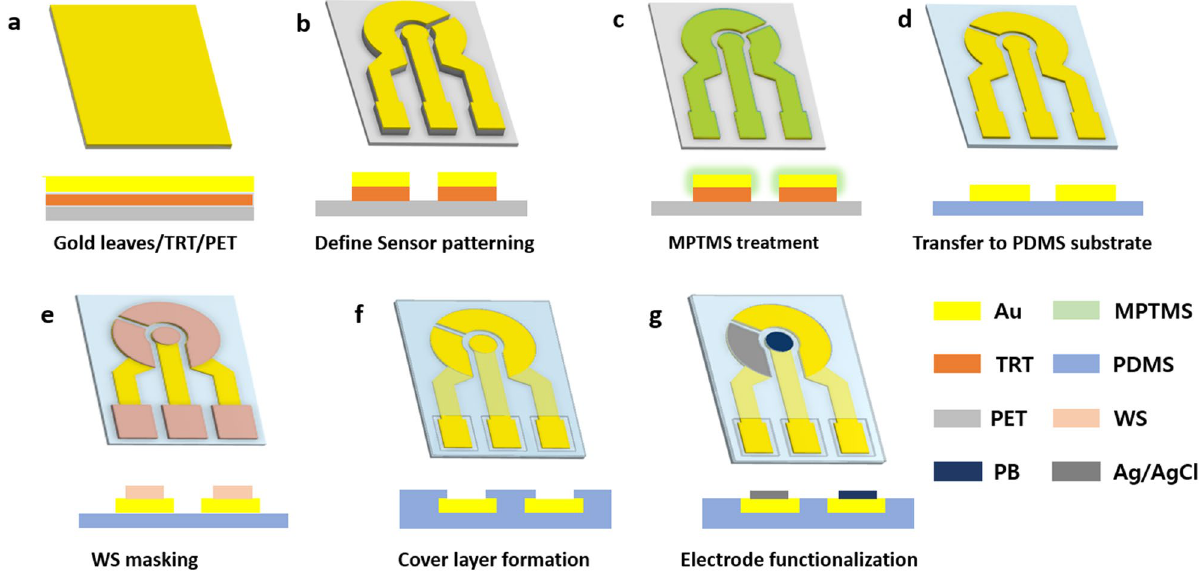
Figure 2. Simple and cost-effective microfabrication process for a flexible and stretchable sensing platform without MEMS equipment. ( a ) Gold leaves mounted on the PET carrier film via the TRT, ( b ) sensor pattern defined by the plotter cutter, ( c ) gold surface treated by MPTMS, ( d ) transfer to the half-cured PDMS substrate, ( e ) sacrificial WS mask pattern transferred on the gold pattern, ( f ) spin coating of the cover layer and dissolution of the WS mask, and ( g ) optional electrode functionalisation with stencil